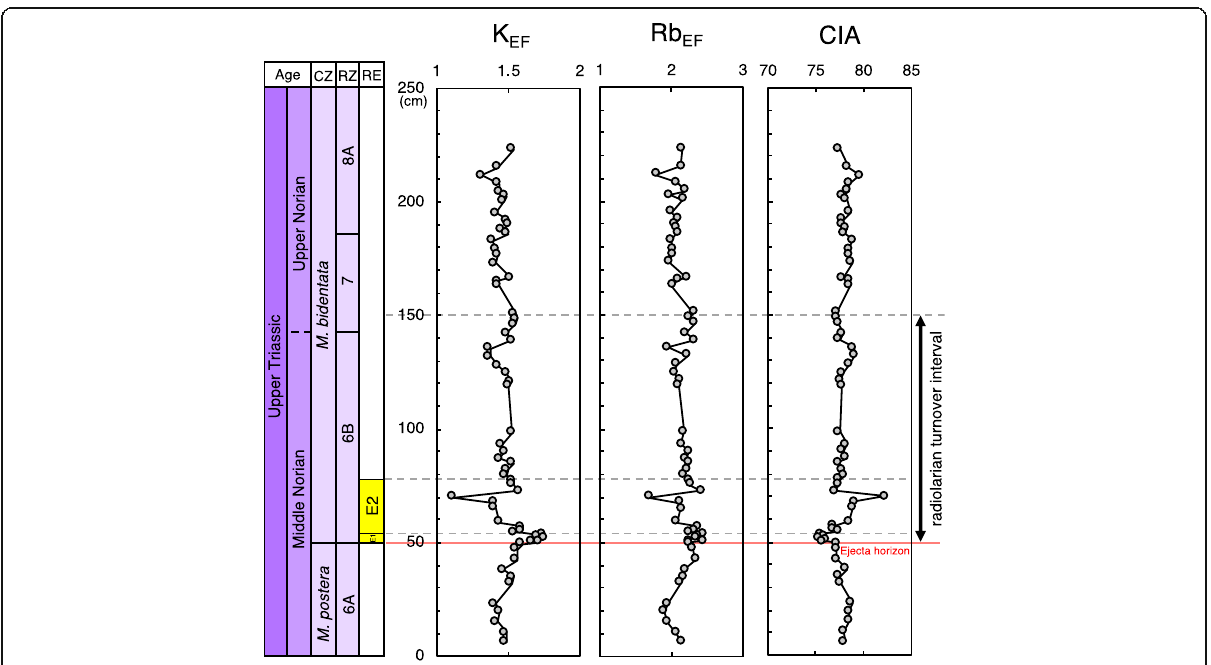
Fig. 8 Stratigraphic profiles of K EF , Rb EF , and CIA in the studied section. Enrichment factors (EF) were calculated relative to UCC (Rudnick and Gao 2014). K EF and Rb EF decrease with increasing CIA values during the E2